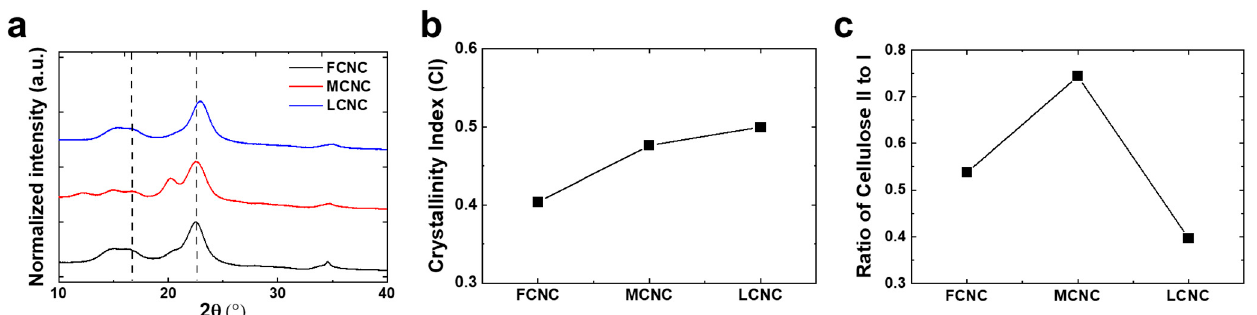
Figure 3. CNC cluster frequency proportions from a variety of CNC samples. ( a ) The bar graphs depict the respective frequency proportions for FCNC, MCNC, and LCNC. Optical microscopic images of ( b ) FCNC, ( c ) MCNC, and ( d ) LCNC suspension with a concentration of 1 wt%.